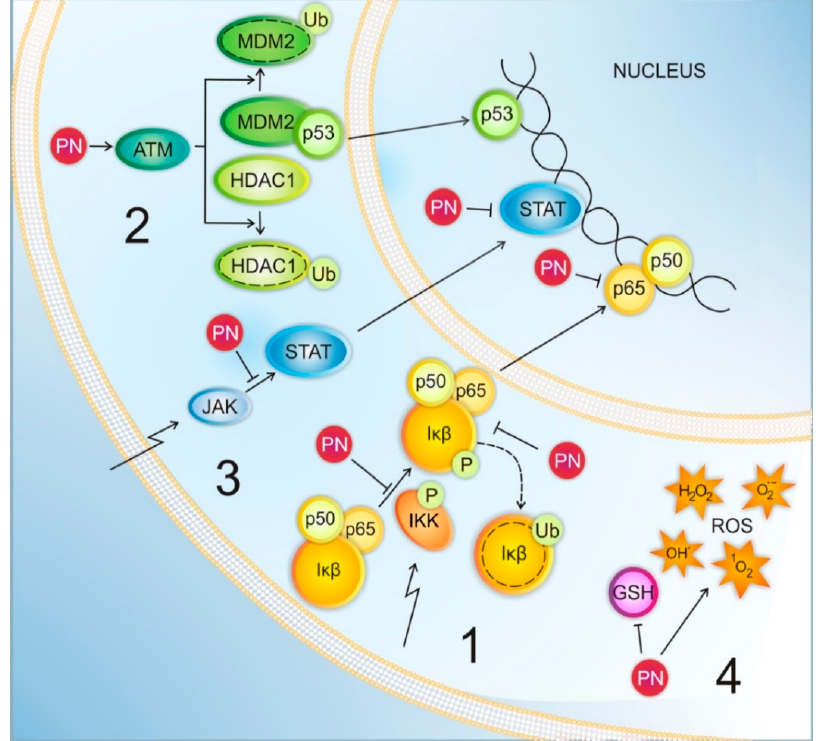
Figure 2. Selected mechanisms of anticancer activity of parthenolide (PN). ( 1 ) Inhibition of nuclear factor kappa B (NF ‐κ B) signaling either through interaction with I κ B kinase (IKK) or directly with p65 subunit results in the downregulation of antiapoptotic gene transcription; ( 2 ) Degradation of the mouse double minute 2 homolog (MDM2) and depletion of histone deacetylase 1 (HDAC1) regulate activity of p53 and increase cancer cells sensitivity to therapy; ( 3 ) Inhibition of signal transducer and activator of transcription protein 3 (STAT3) phosphorylation prevents its dimerization, nuclear translocation and STAT3 ‐ dependent gene expression; ( 4 ) Reduction of cellular level of glutathione (GSH) and reactive oxygen species (ROS) accumulation induce oxidative stress. Suppressed NF ‐κ B activation is correlated with sustained c ‐ Jun N ‐ terminal kinase (JNK) activation followed by tumor necrosis factor α (TNF ‐α ) ‐ mediated cell death of cancer cells [60]. PN ‐